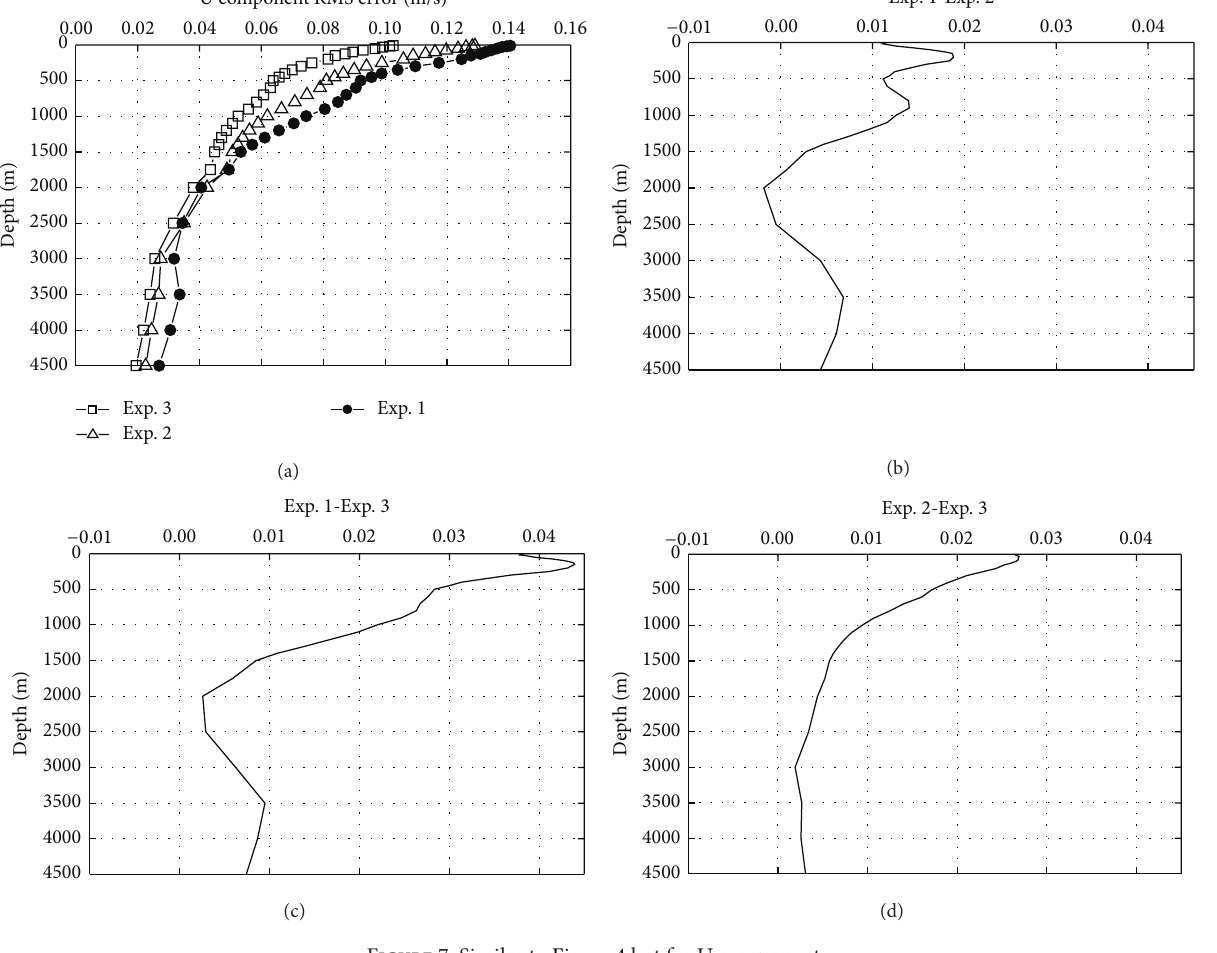
Figure 7: Similar to Figure 4 but for U